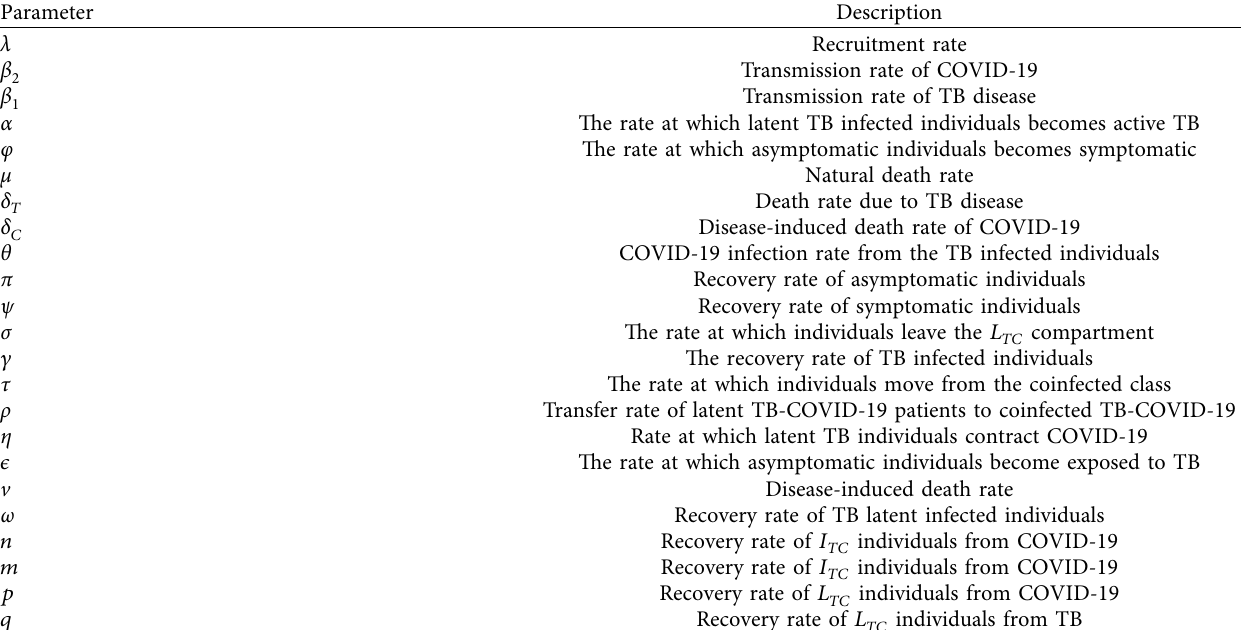
Table 1: Parameter and